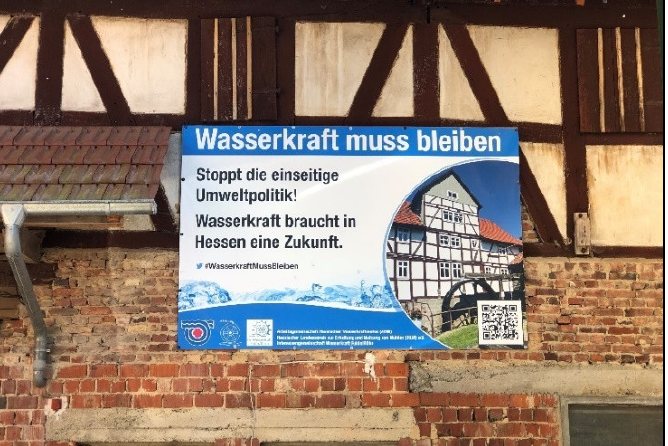
Figure 24. Protest of operators of small hydropower plants against stricter environmental flow regulations in the federal state of Hesse, Germany, affecting ca. 400 water mills (“hydropower must stay—stop the one-sided environmental policy—hydropower needs a future in Hesse”. Photo by J. Dietrich).